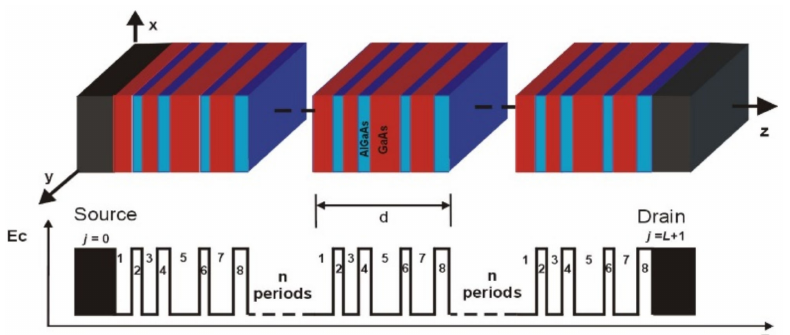
Figure 1. A fragment of AlGaAs-GaAs superlatice and illustration of periodic potential (with period d and number of the semiconductor layers L) , which it is created in the material as a result of the modulation arrangement of the semiconductor layers. The layer sequence of one period in nanometers is: 7.8, 2.4 , 6.4, 3.8 , 14.8, 2.4 , 9.4, 5.4 nm. AlGaAs layers are denoted in bold and the underlined layers is n